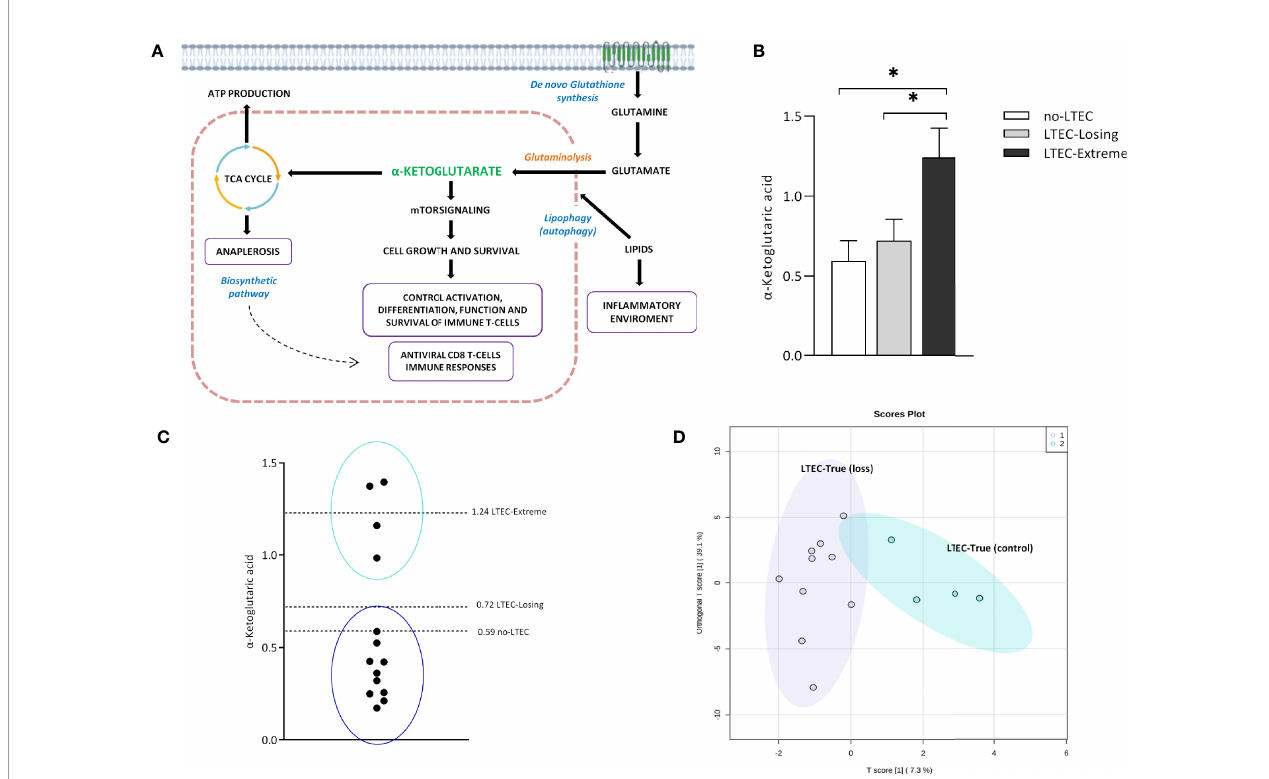
FIGURE 4 | a -Ketoglutaric acid and the lipid panel distinguish two subgroups in long-term elite controller (LTEC)-true. (A) Overview of the principal a -ketoglutarate pathways implicated in the antiviral state in the LTEC-extreme patients: mTOR signaling for the control of T immune cells and the biosynthetic pathways in the tricarboxylic acid (TCA) cycle associated with the cell growth and survival. Right: the possible in fl ammatory environment created by increased lipidic concentrations as the mechanism operating behind the loss of immunological and/or viral control in LTEC-losing patients (created with BioRender.com (2021); retrieved from https:// app.biorender.com/biorender-templates). (B) Increased plasmatic levels of a -ketoglutaric acid in LTEC-extreme compared to other LTEC phenotypical groups (*P < 0.05). (C) Relative plasmatic concentrations of a -ketoglutaric acid distinguish the classi fi cation of two subgroups among the 14 LTEC-true individuals. (D) Orthogonal principal component analysis (ortho-PCA) of the combination of 45 lipid species signi fi cantly increased in the LTEC-losing group differentiates both subgroups of